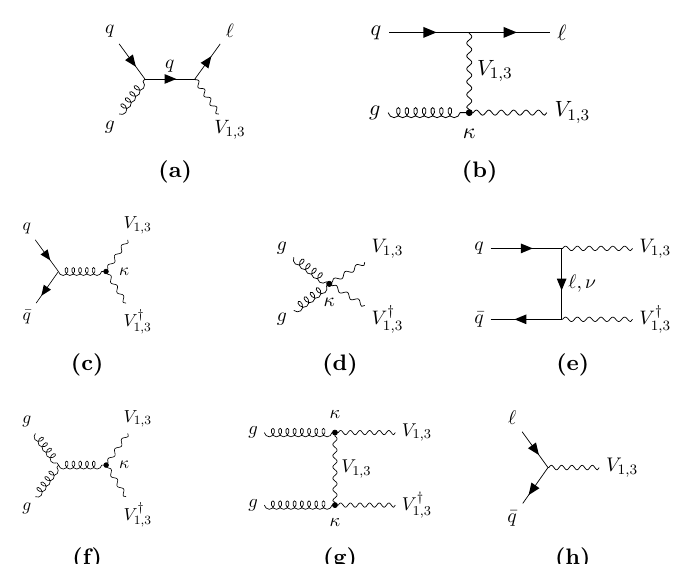
Figure 1 . Leading order Feynman diagrams for single production, (a) and (b), pair production, (c) - (g), and resonant production, (h), of the V 1 and V 3 vector leptoquarks. The dots indicate additional contributions stemming from the coupling with the gluon field strength tensor proportional to κ . Notice the crossed versions of diagram (g), which are not shown